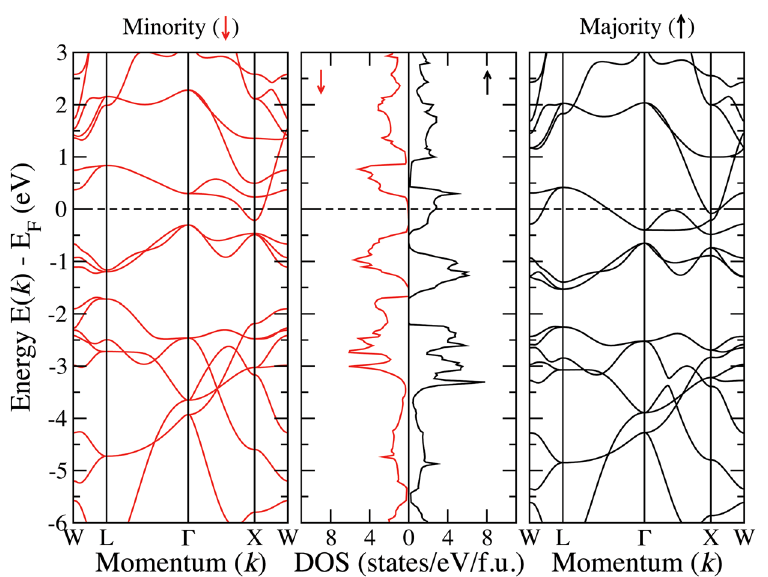
Figure 9. Spin-resolved band structure and density of states for